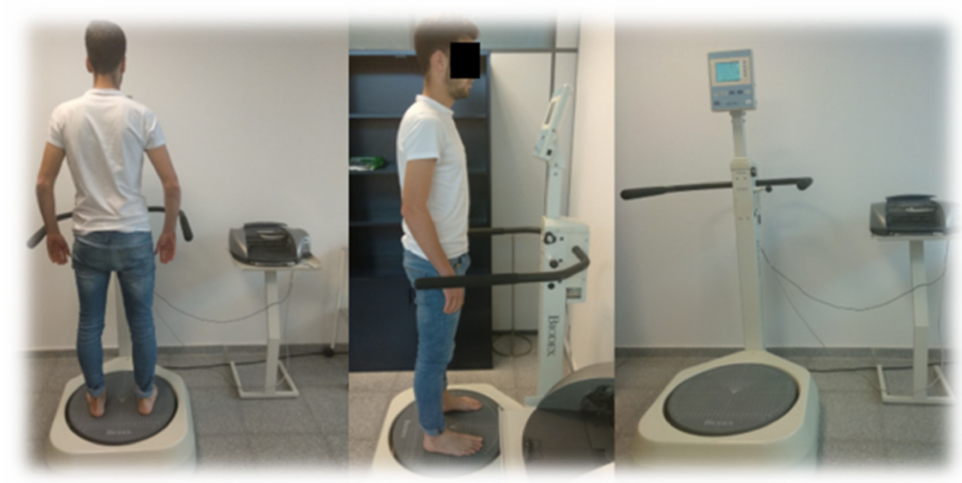
Figure 3. Biodex Balance System ™